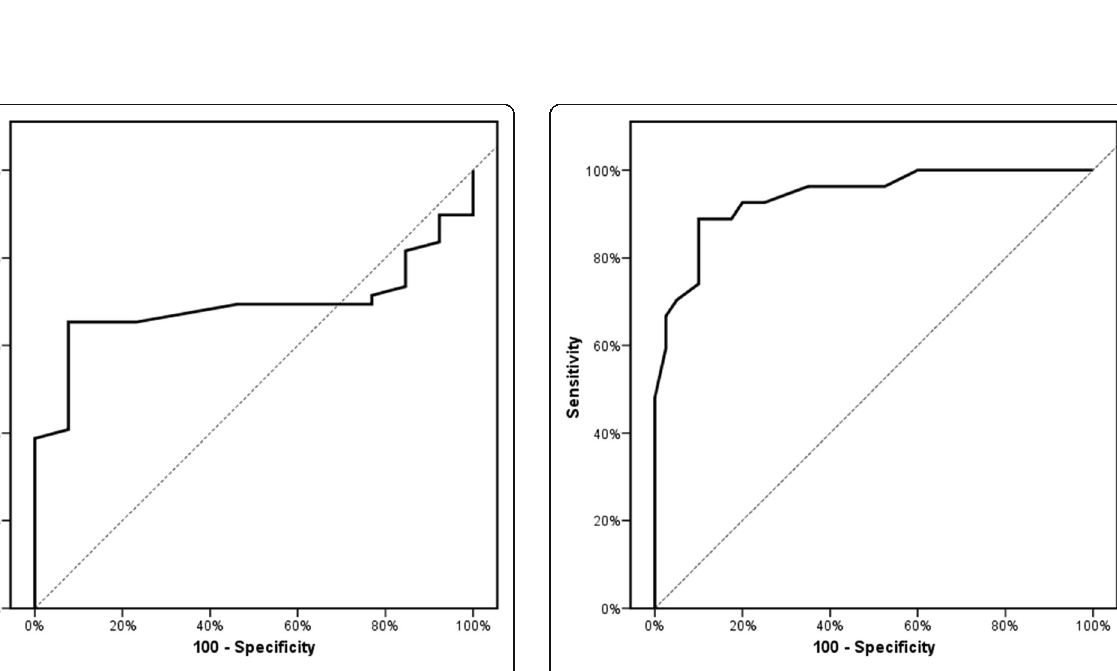
Fig. 3 ROC curve to assess agreement (sensitivity, specificity) of the ADC ratio to diagnose malignant from benign neoplastic lesions. Cutoff ADC ratio of > 0.52 × 10 − 3 mm 2 /s can be used to diagnose malignant from benign neoplastic lesions with a sensitivity of 65.31% and specificity of 92.1%